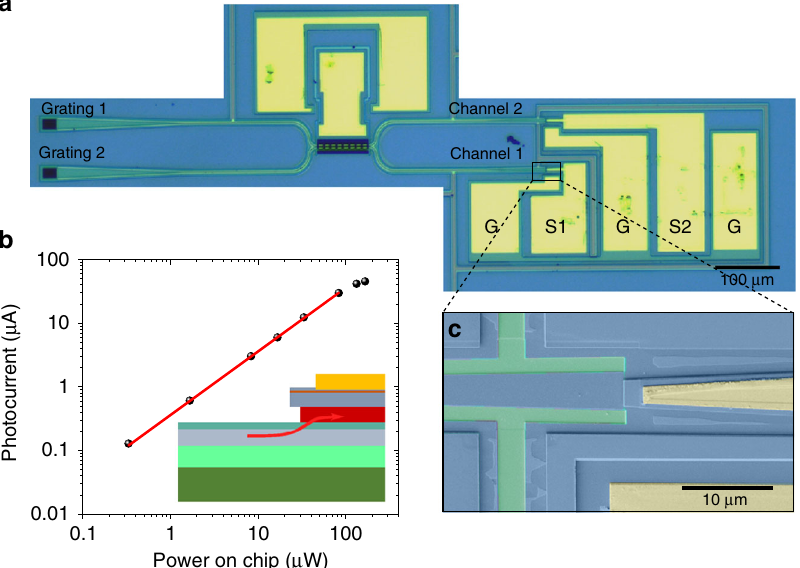
Fig. 3 Integrated sensor and response of the photodiode. a Optical microscope image of the integrated displacement sensor. G stands for ground, S1 and S2 stand for signal of channel 1 and channel 2. b Photocurrent measured on a waveguide photodiode connected directly with a grating coupler at 1540 nm as a function of power on chip. Linear fi t of the photocurrent with power under 100 µ W is indicated by red line. Inset: Schematic of the integrated photodiode. Red arrow marks the direction of incoming light. c SEM image of the integrated photodiode in false colors.